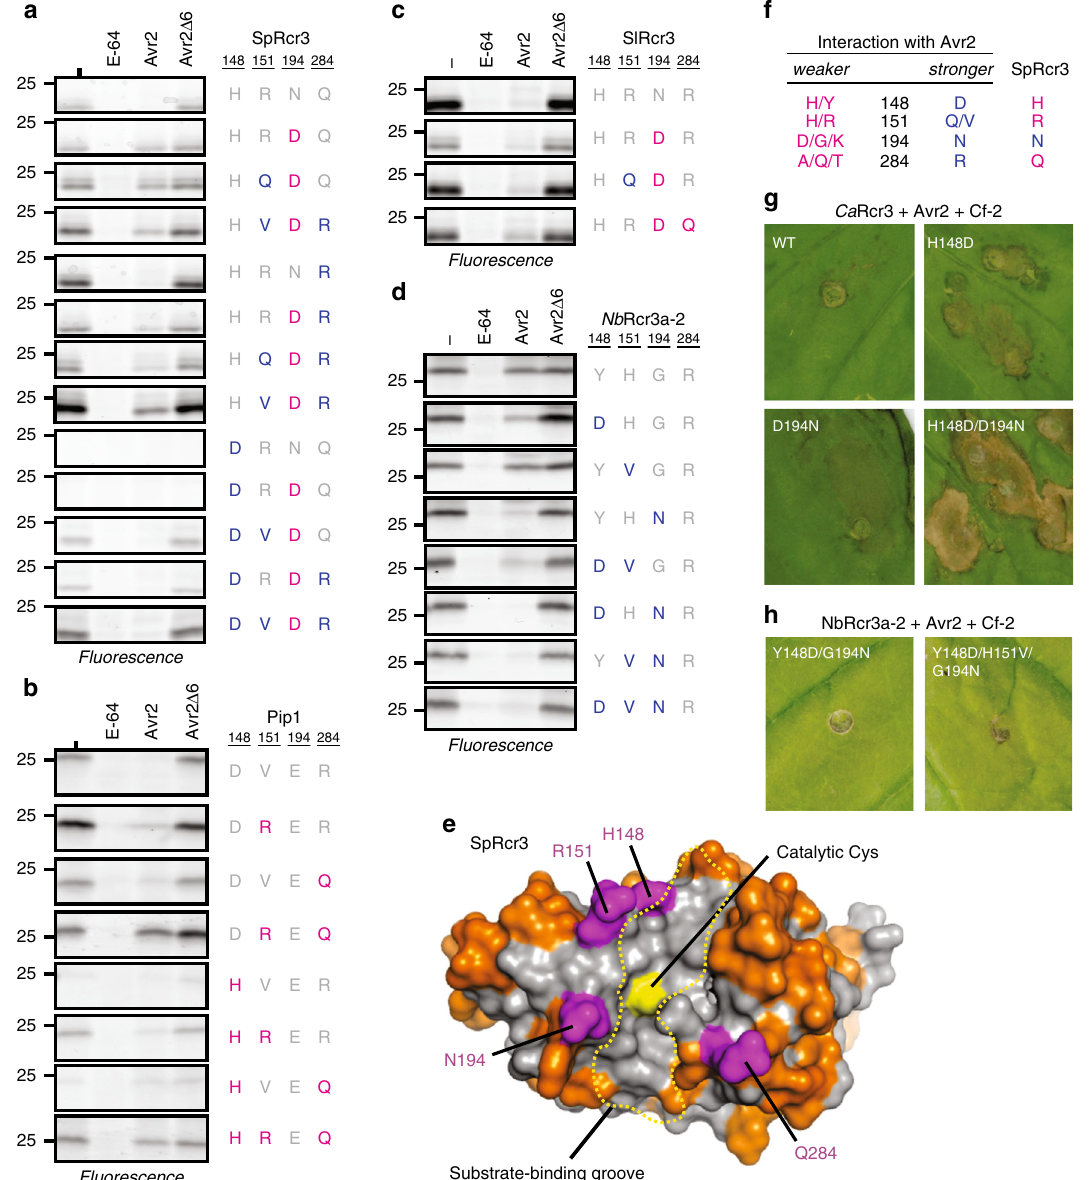
Fig. 6 PLCP inhibition by Avr2 is determined by four residues. Substitution mutants of Sp Rcr3 ( a ), Sl Pip1 ( b ), Sl Rcr3 ( c ), and Nb Rcr3a-2 ( d ) were produced by agroin fi ltration of N. benthamiana leaves. Apoplastic fl uids were isolated at 2 dpi, preincubated for 45 min with or without 100 µ M E-64, 2 µ M Avr2 or Avr2 Δ 6, or DMSO, and labelled for 3 h with 2 µ M MV201. Samples were separated on SDS-PAGE gels and scanned for fl uorescence. e H148, R151, N194, and Q284 residues (magenta) locate around the substrate-binding groove in Rcr3. Homology model of Sl Rcr3 based on 1s4v 10,68 . Shown are the substrate-binding groove (dotted line), catalytic cysteine (yellow), and polymorphic residues between Sp Rcr3 and Sl Pip1 (orange). f Summary of the effect of variant residues on inhibition by Avr2, compared to residues present in Sp Rcr3. g Pepper Rcr3 ( Ca Rcr3) substitutions enhance Avr2-triggered HR. h Nb Rcr3a-2 that carry substitutions enhancing inhibition by Avr2 without triggering HR. Mutant Ca Rcr3 or Nb Rcr3a-2 were transiently co-expressed with Cf-2 and Avr2 by agroin fi ltration and pictures taken at 5